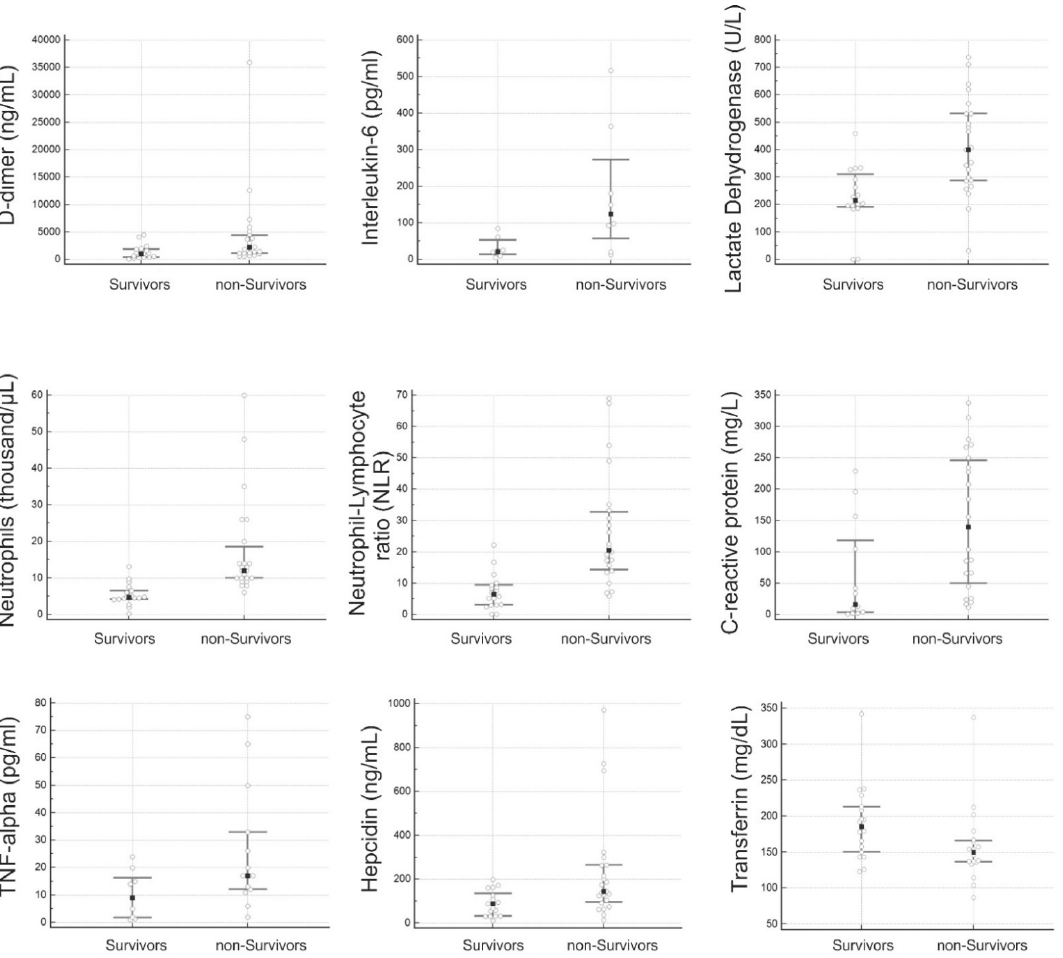
Figure 1. Serum levels of laboratory parameters significantly different in non-survivors’ and survivors’ groups (Mann–Whitney U test). Finally, ROC curve analyses were performed on the laboratory parameters with sig- nificant differences. Data obtained are reported in Table 2. LDH and IL-6 showed the best sensitivity (95%) and specificity (100%) values, respectively. Results for all other routine parameters are in line with the current literature. Hepcidin showed good sensitivity and specificity values of 74% and 76%, respectively, at a cut-off of 127 (ng/mL) with an AUC of 0.813 (Figure 2). Thus, a value of hepcidin lower than 127 (ng/mL) at hospital admission is suggestive of a favorable prognosis, also used alongside other biomarkers.